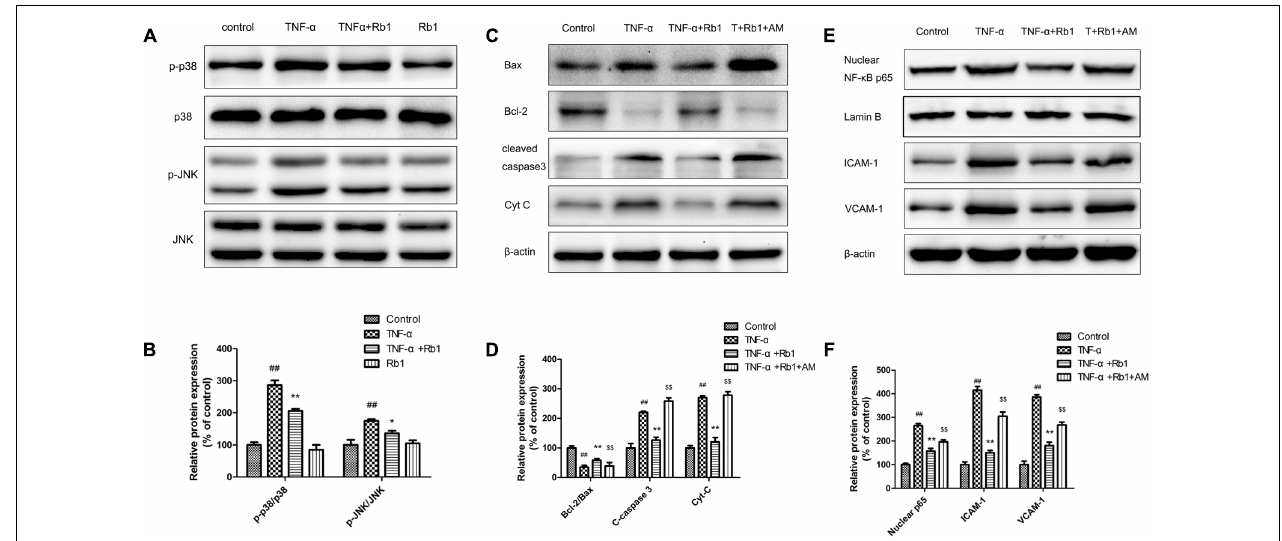
FIGURE 7 | The protective effects of ginsenoside Rb1 on TNF- α -induced injury in HUVECs are p38 and JNK-pathway dependent. HUVECs were incubated with ginsenoside Rb1 (20 µ g/mL) for 8 h before treatment with TNF- α for 24 h. (A) The expression levels of phosphorylated and total JNK and p38 were detected by western blot. (C,E) Ginsenoside Rb1 suppressed NF- κ B nuclear translocation and regulated apoptosis-related protein expression by inhibiting the JNK and p38 pathway. (B,D,F) Densitometric analysis was performed to quantify protein expression levels. Data were expressed as the mean ± SD of three independent